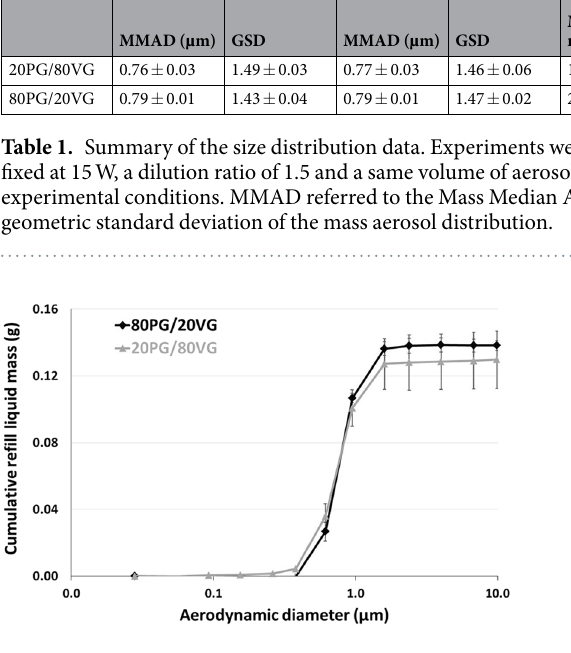
Figure 3. DLPI Impactor-collected data showing the impact of the PG/VG ratio on the cumulative mass distribution of refill liquid (expressed in mg). Experiments were performed in triplicate with a power level fixed at 15 W, a dilution ratio of 1.5 and a same volume of aerosol collected into the cascade impactor for all experimental conditions.